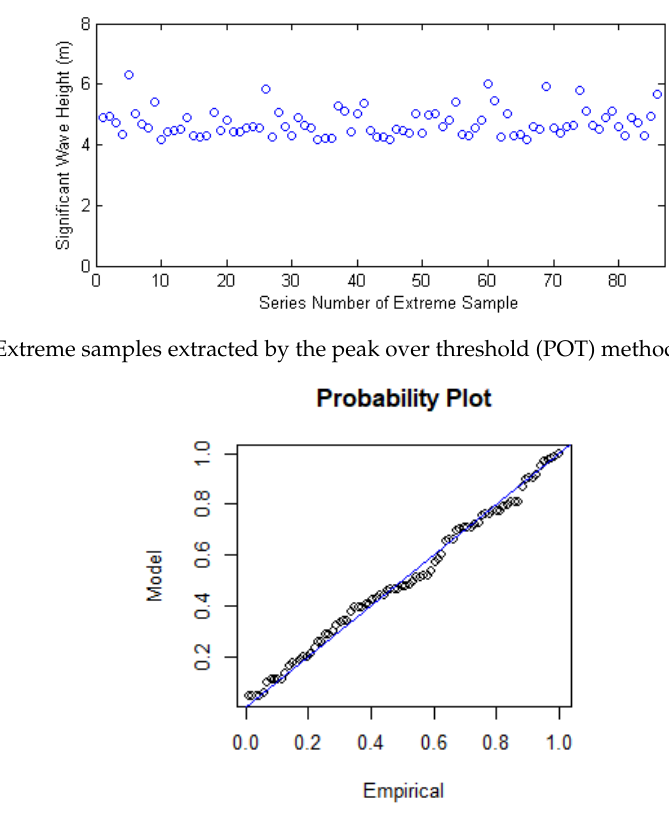
Figure 9. The probability plot for the POT/generalized Pareto distribution (GPD) method at location S1.